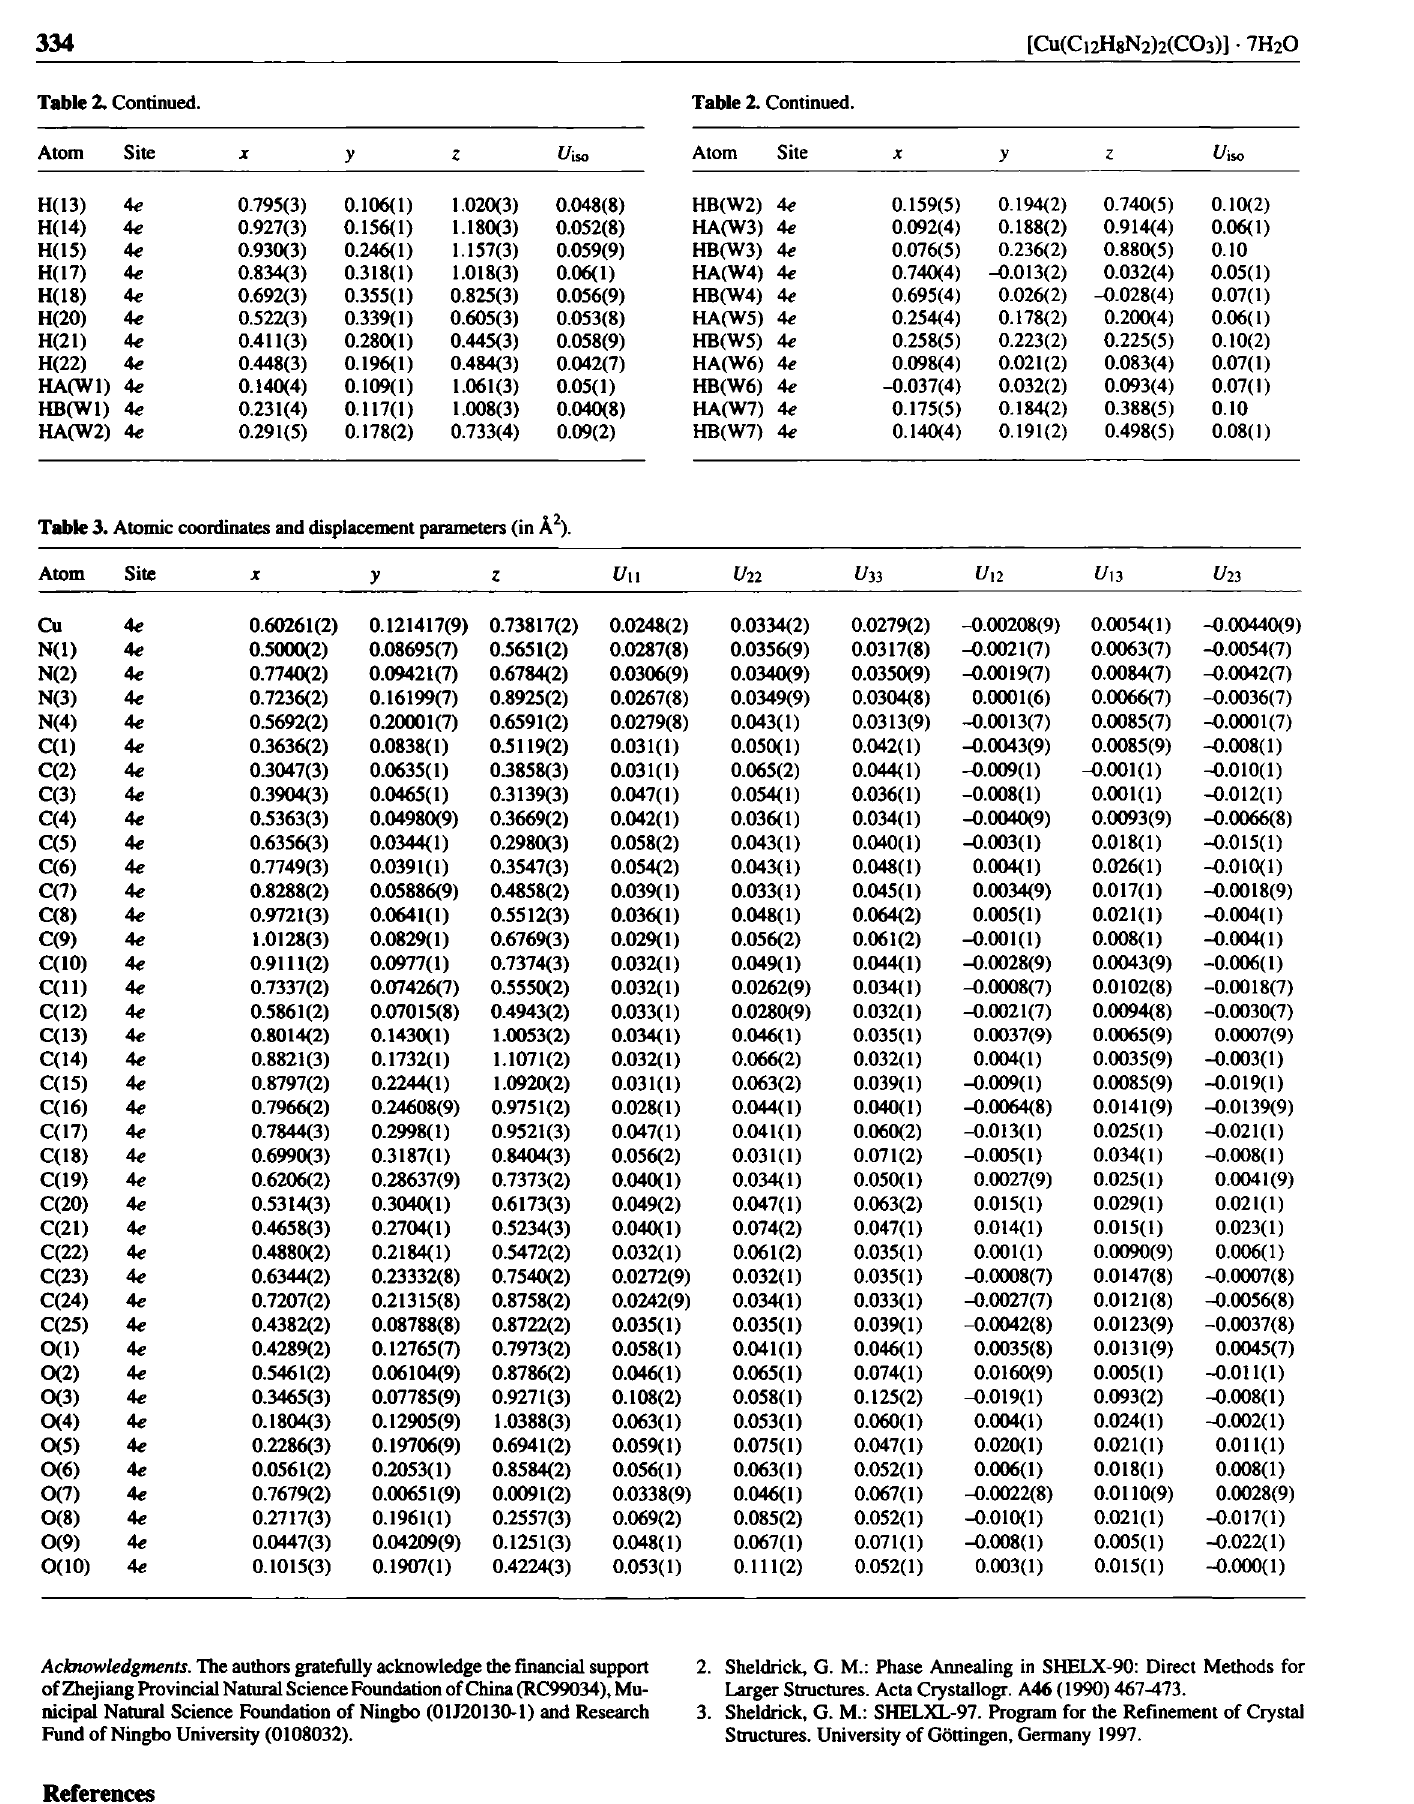
Table 3. Atomic coordinates and displacement parameters (in Â 2